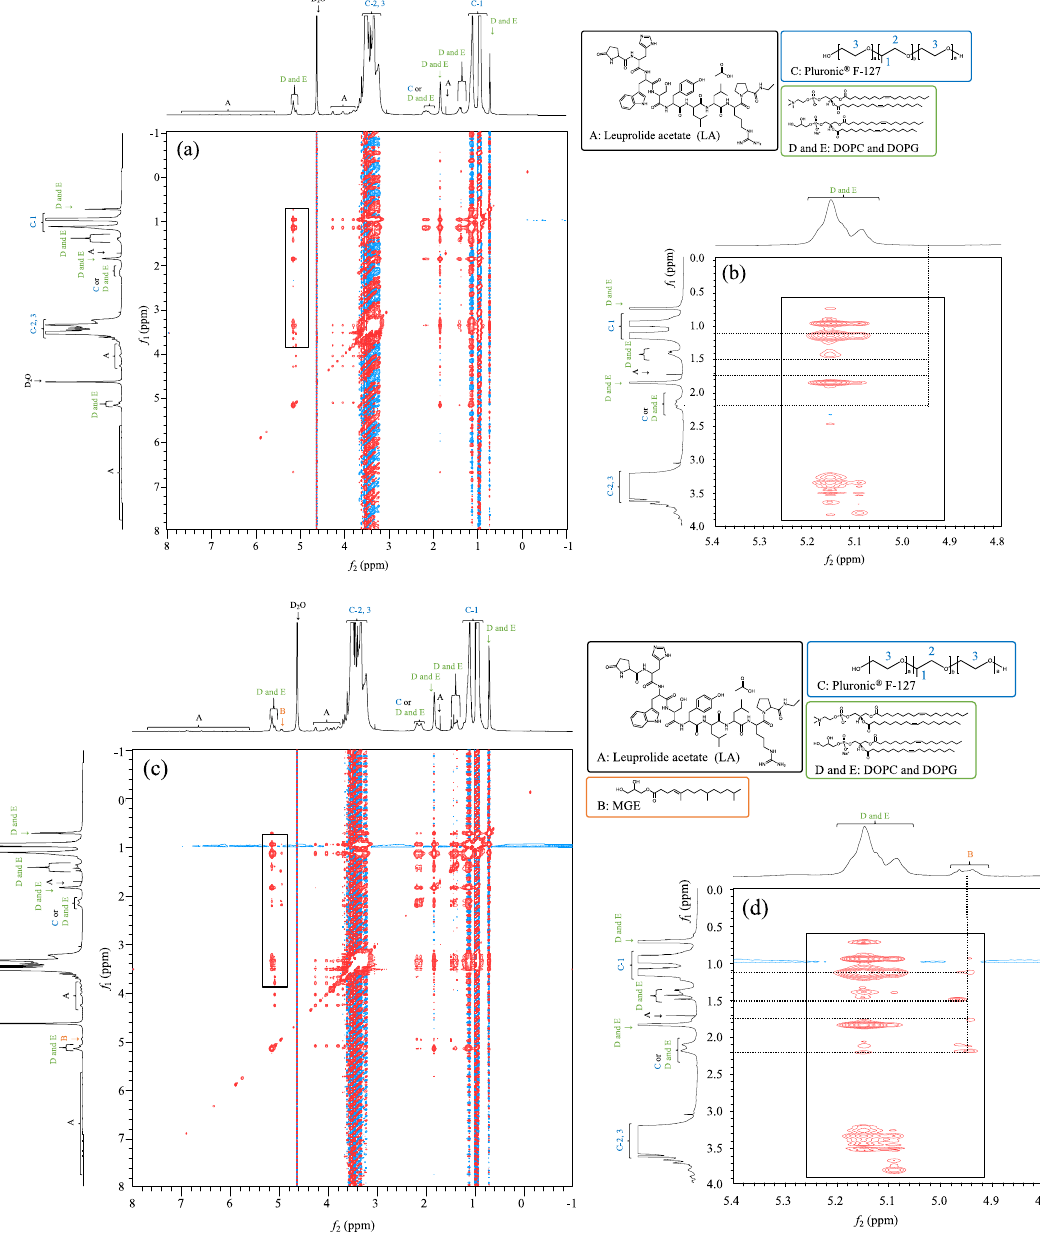
Figure 6. {1H-1H} NOESY NMR spectroscopy of P ( a , b ) and MP 10 ( c , d ). ( b , d ): enlarged areas of the black boxes in ( a , c ), respectively.